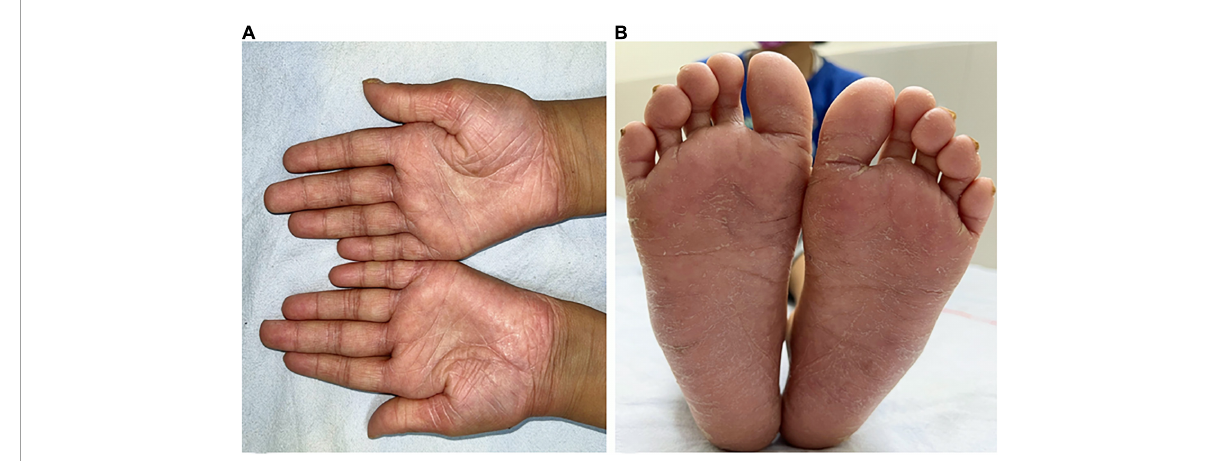
FIGURE1 Diffuse erythematous hyperkeratotic scaling and fissuring in the (A) palm and (B) sole (B) of case 2.